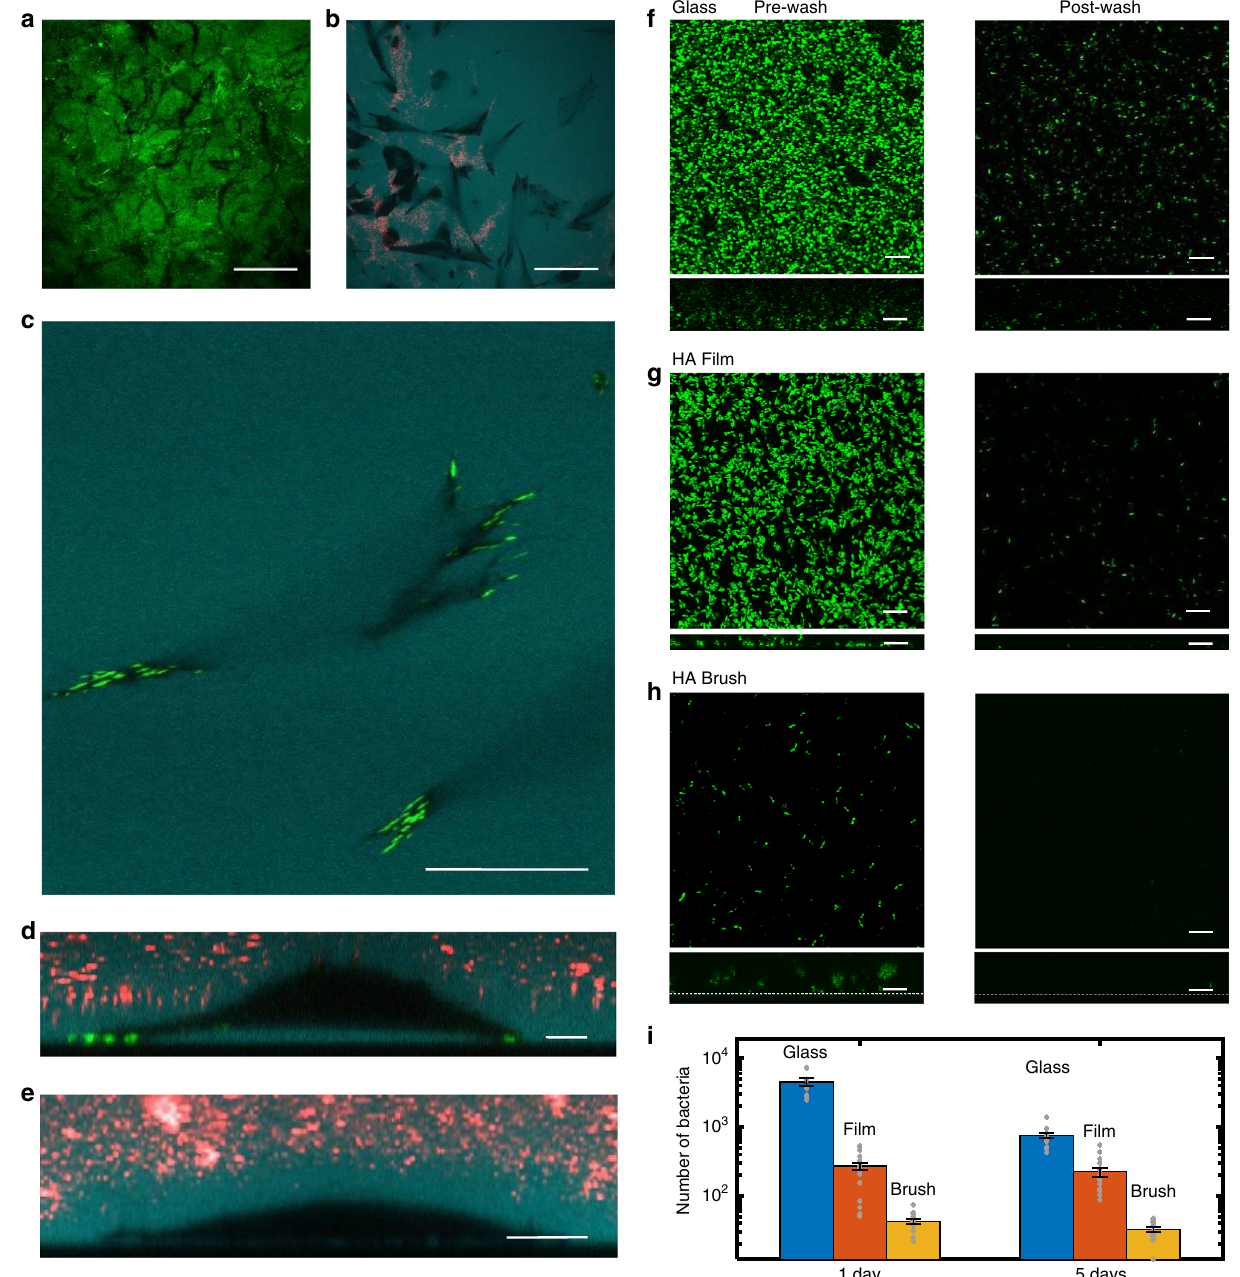
Fig. 6 Fibroblast and bio fi lm interactions with HA brush. a Black tracks in the GFPn-labeled HA brush reveal areas of brush digestion by MEF cells. Scale bar 50 µ m. b Fluorescent dextran (cyan) highlights space under adherent cells (to the brush). Black regions correspond to cell area in close contact with surface. Red fl uorescent particles fi ll areas of brush elimination due to digestion by cells. Scale bar 50 µ m. c Fibroblasts attach to the interface underlying the HA brush, expressing mature focal adhesions (green, vinculin). Dextran is apparent underneath the spread cell. Scale bar 20 µ m. d z -slice of the same adherent fi broblast from ( c ) sitting on a cushion of HA. Scale bar 10 µ m. e Particle exclusion assay reveals MEFs express a thick glycocalyx. All MEF images were taken after 12 h exposure to the HA reinforced brush. Scale bar 10 µ m. f − h Confocal micrographs of GFP-producing Pseudomonas aeruginosa (PAO1) interacting with a glass interface ( f ), an HA fi lm ( g ), and a reinforced HA brush ( h ). All images were taken at the glass interface. Left: bio fi lm growth before washing (1 day). Right: bio fi lm growth after washing (1 day). Dextran was used to identify the glass interface beneath the brush. XZ side views of the bio fi lms are presented below each respective XY top view of the samples. Scale bars, 10 µ m in ( f − h ). i Comparison of the number of bacteria retained after washing different surfaces. Data were taken in triplicates and averaged over fi ve regions per sample. Error is SEM. Data are available in Table 3 in the Supplementary